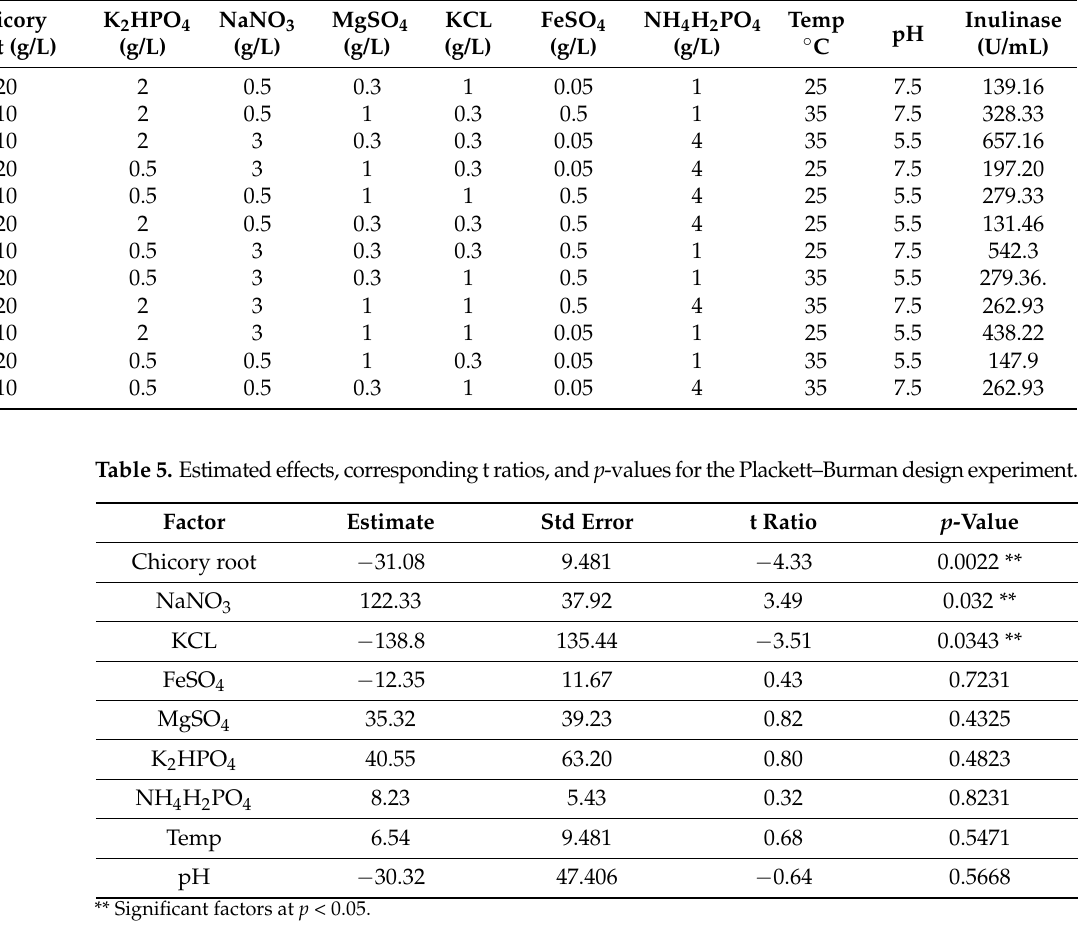
Table 6. Box–Behnken factorial experimental design and responses of inulinase activity produced. Chicory NaNO 3 Pattern Root (g/L) (g/L)